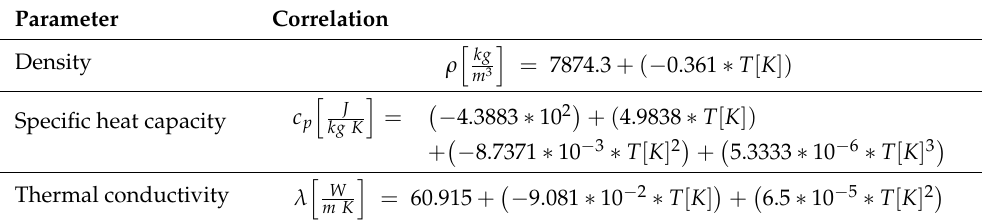
Table 1. Eurofer thermo–physical properties.